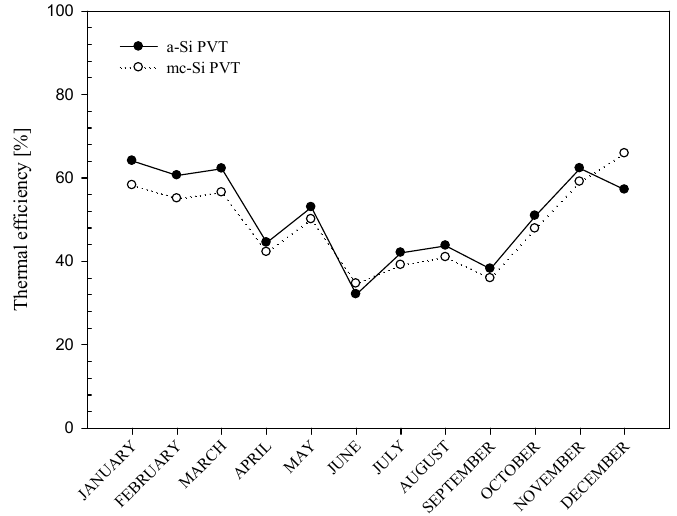
Figure 13. Thermal efficiency of experimental of PVT collector.